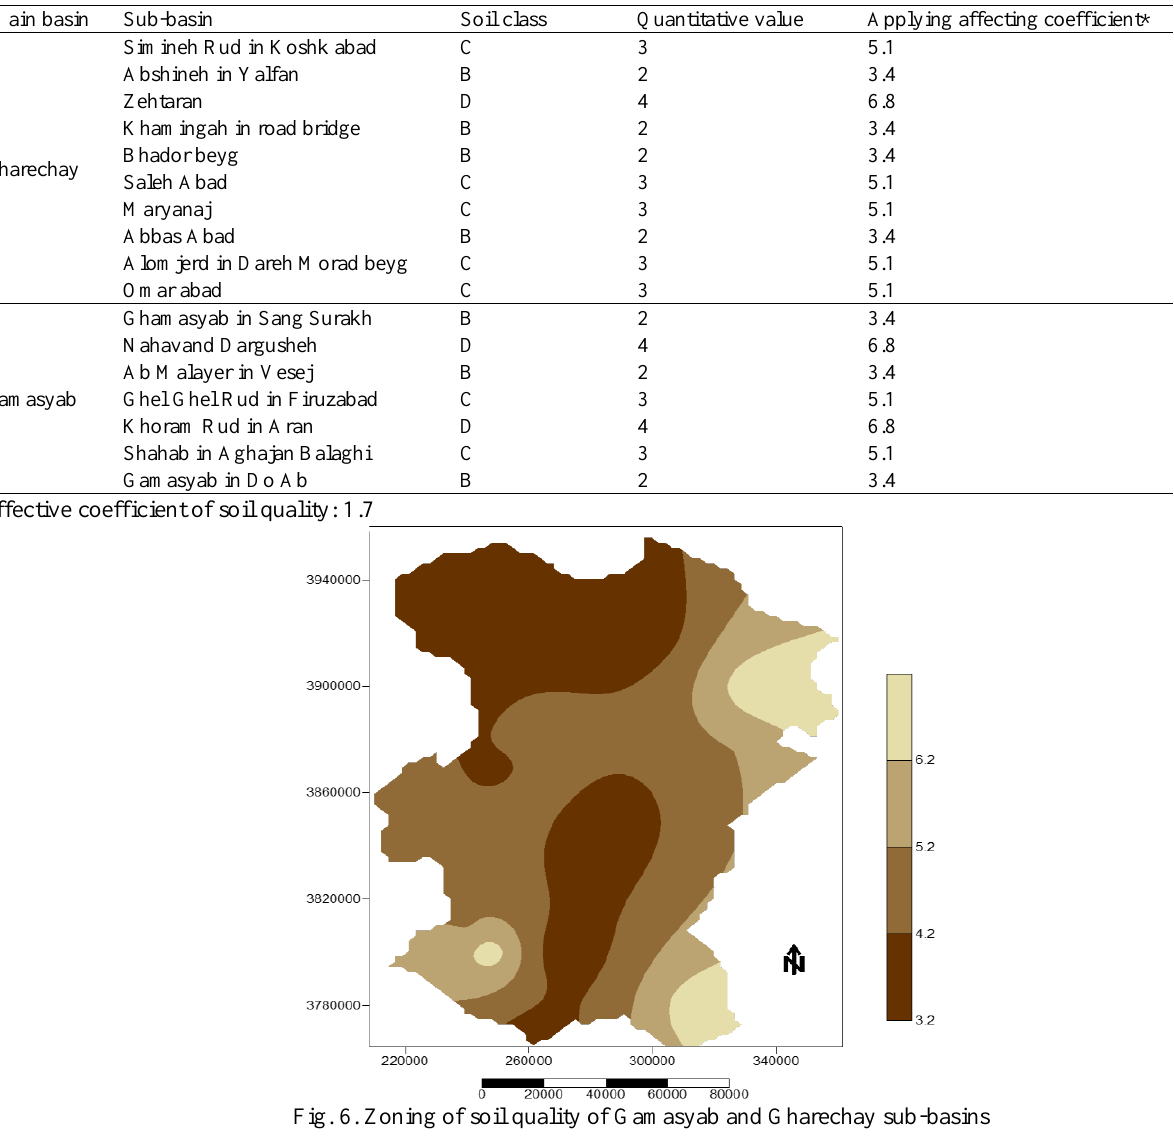
Table 5. Soil infiltration classification of Gamasyab and Gharechay sub-basins based on SCS classification with quantitative coefficients